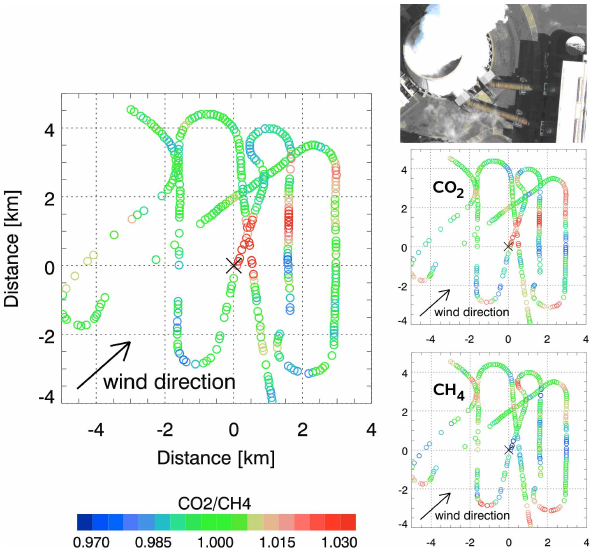
Fig. 12. Left: normalized MAMAP CO 2 /CH 4 profile scaling factor ratio (PSFR BM ) retrieved from measurements acquired on 26 July 2007 over the power plant J¨anschwalde (black cross) located north of Cottbus (south-east of Berlin) in Eastern Germany, right: photo automatically taken during the flight over the power plant (top), dimensionless CO 2 profile scaling factors (middle), and di- mensionless CH 4 profile scaling factors (bottom). All values shown in a given map as part of the flight have been scaled with a constant factor such that the scaled values of the whole flight are close to unity (green). The data have been smoothed using a seven point moving average and high-pass filtered with a 80 point high-pass filter. Gaps are due to the quality filtering (shown are only mea- surements where the spectral signal was larger than 3000 counts after dark signal correction and the root-mean-square (RMS) of the fit residuum, i.e. the relative difference between measurement and model after the fit, is better than 1%). The CO 2 output of the power plant during the overflight was 56.6tmin − 1 (Dietmar Heinze, Vat- tenfall Europe Generation AG&Co. KG, Cottbus, Germany, per- sonal communication,